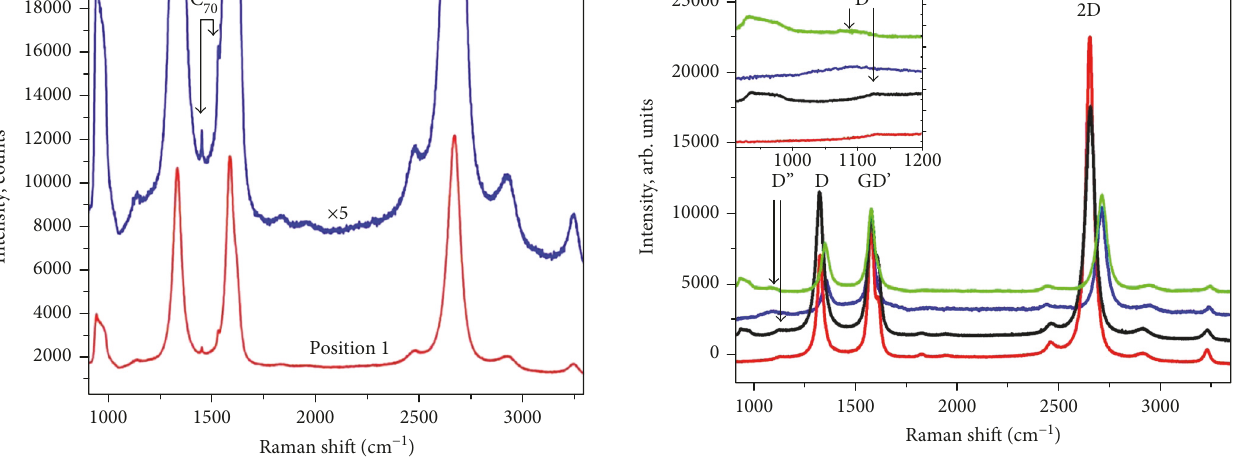
Figure 5: The Raman spectrum of the interlayer (point 1, Figure 1(c)) of α C after exfoliation by Scotch tape. The features observed at about 1450 and 1530 cm − 1 are typical for C